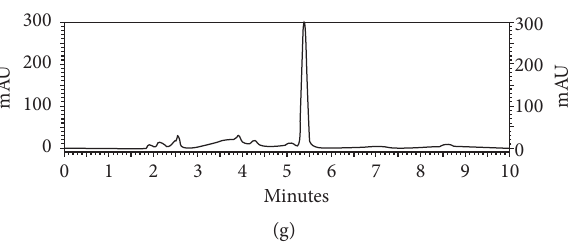
Figure 1: HPLC chromatograms of (a) standard nitrate (25 μ g/mL): nondefatted C. anisata extract (2.5mg/mL) obtained from (b) de- coction, (d) infusion, and (f) UAE and defatted C. anisata extract (2.5 m g/mL) obtained from (c) decoction, (e) infusion, and (g)